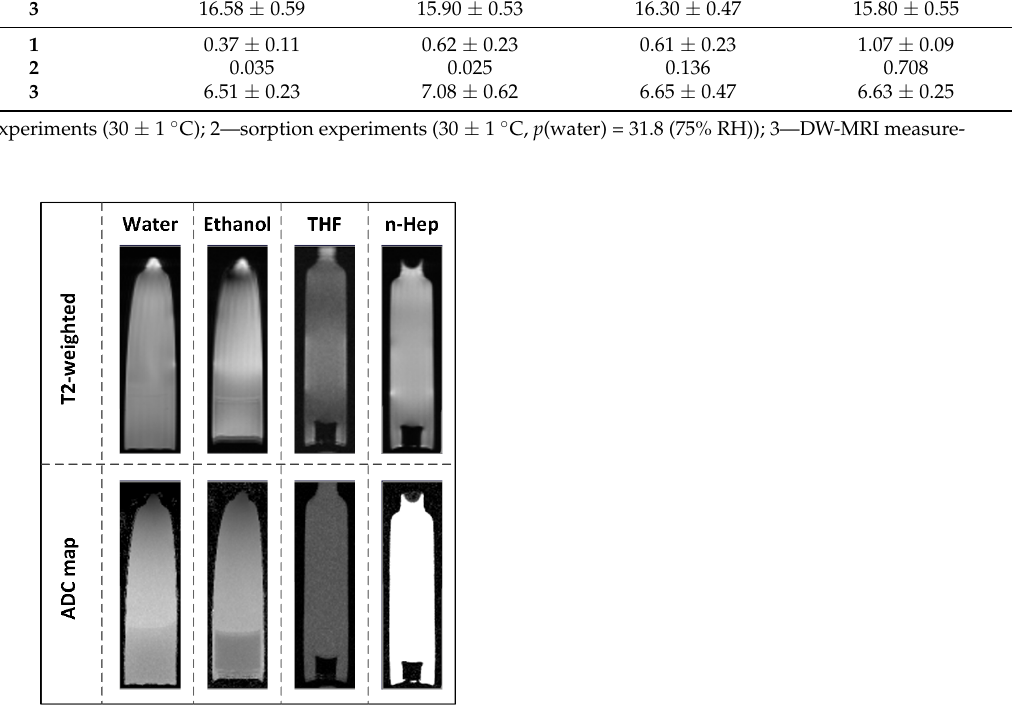
Figure 6. T2-weighted visualization and ADC map of the solvent diffusion in poly(VEImBr) (21.5 ± 2 °C; TR: 2500.0; TE: 35.0; MBAA: 2 mol%). Table 6. Summary of all diffusion coefficients measured using different methods.